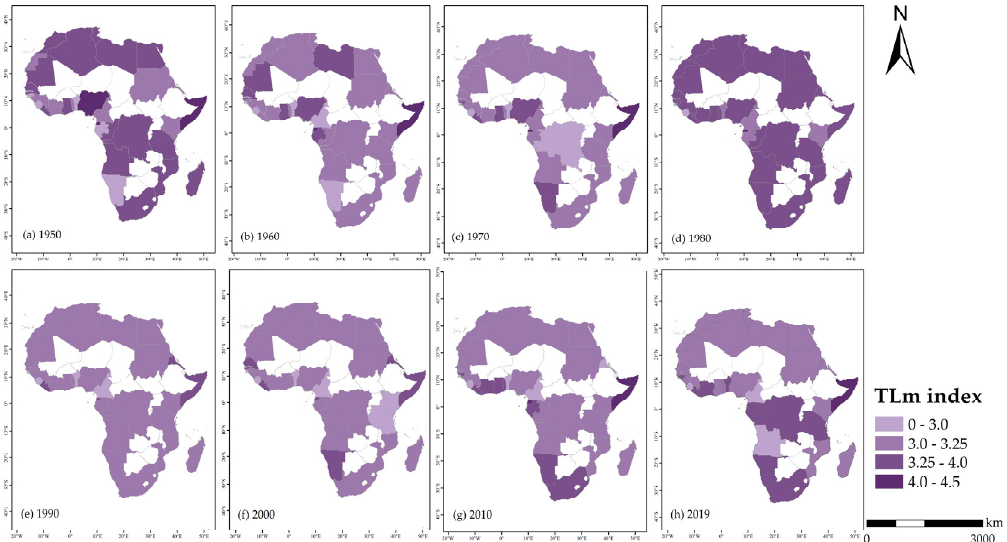
Figure 5. Spatial distribution of TLm index in Africa during 1950–2019, by decade. Note: The results were calculated according to Formula (1).